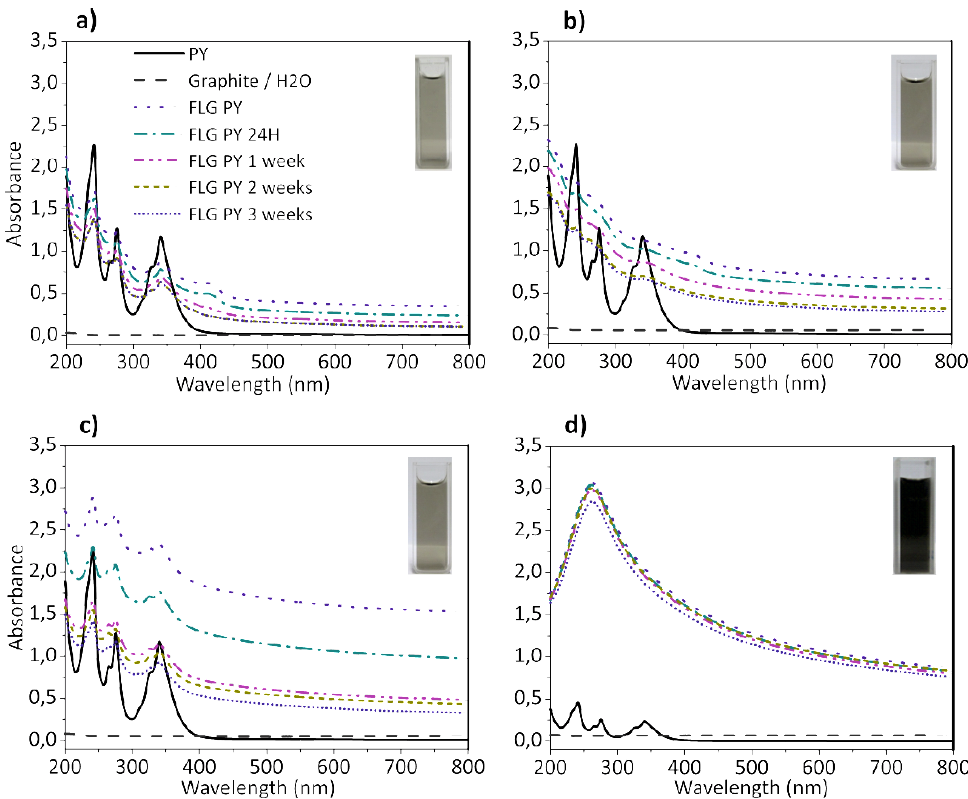
Figure 2. UV-visible spectra of the stable dispersions of exfoliated graphite, as prepared, and of the pyrene derivative solution for: ( a ) Graphexel; ( b ) Micrograf; and ( c ) grade 5 graphite nanoplatelets (GnPH5). ( d ) UV-visible spectra of the 10 × diluted grade C graphite nanoplatelets (GnPC) dispersions and the pyrene solution.